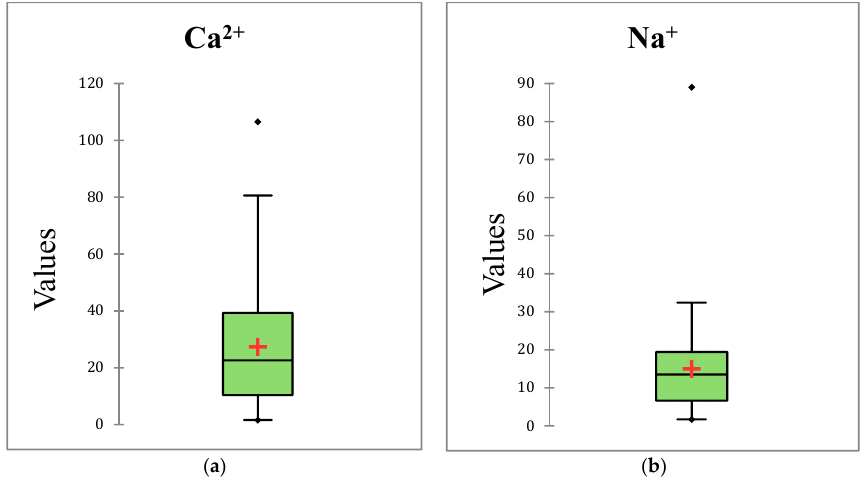
Figure 3. a ) Ca 2+ variation. b ) Na + variation. Figure 3. ( a ) Ca 2 + variation. ( b ) Na +